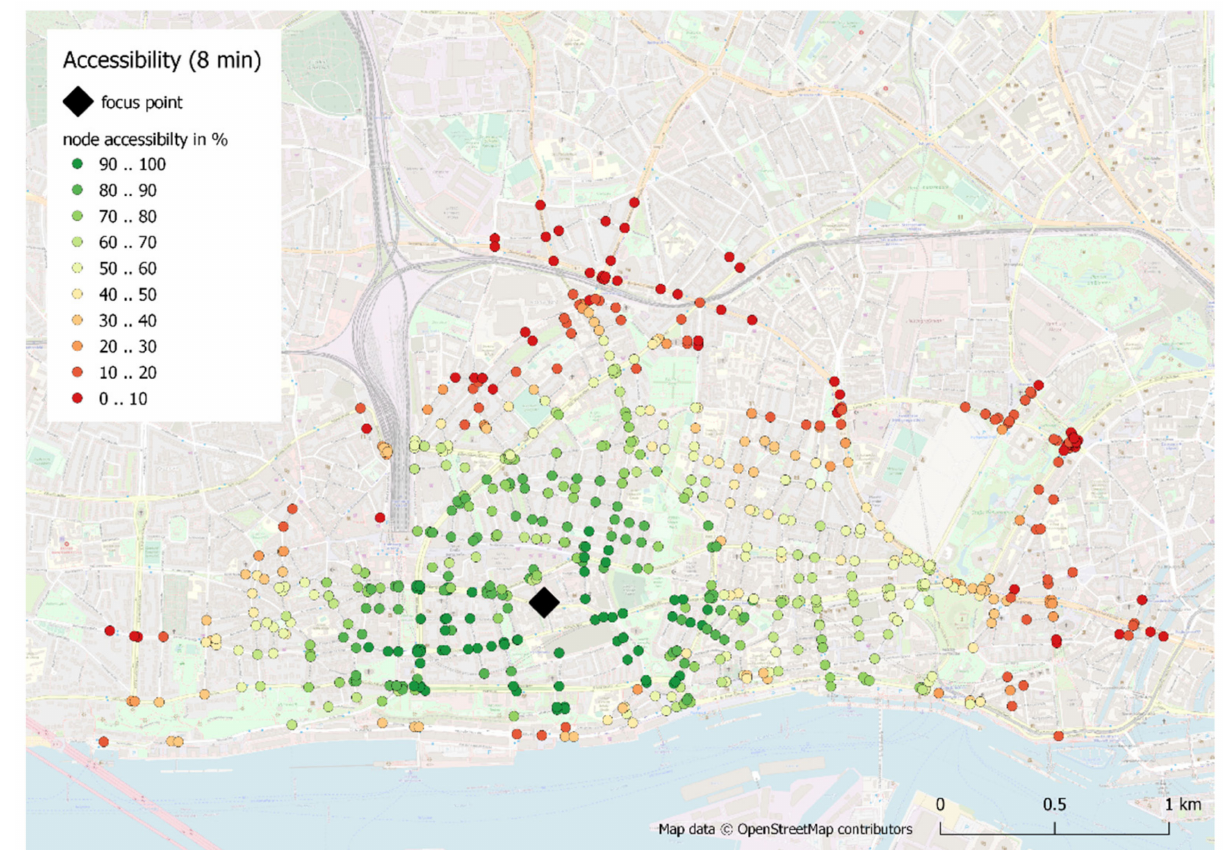
Figure 8. Example 4: Spatial variance around eight minutes’ isochrones, expressed by frequency with that points could be accessed within eight minutes although randomly placed closures